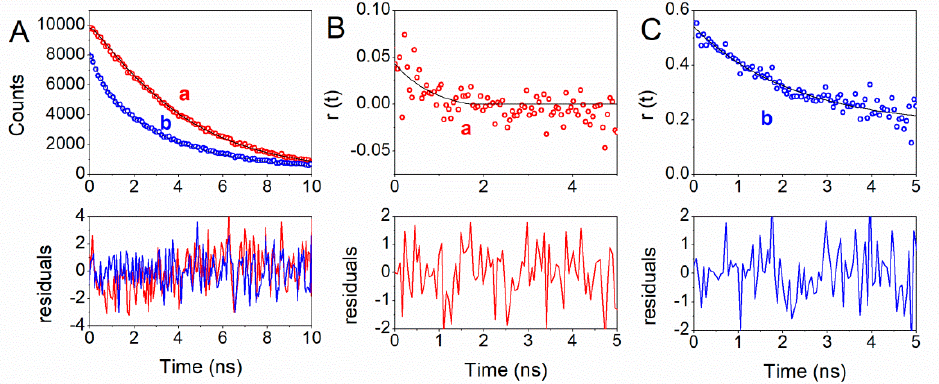
Figure 3. Fluorescence time decay ( A ) and time-resolved fluorescence anisotropy ( B , C ) of a) Ada-Rhod 100 µ M in DCM and b) PolyCD@Ada-Rhod / DCF (0.5 mg / mL, [Ada-Rhod] = 8 µ M, [DCF] = 236 µ M) in ultrapure water at room temperature (r.t.).